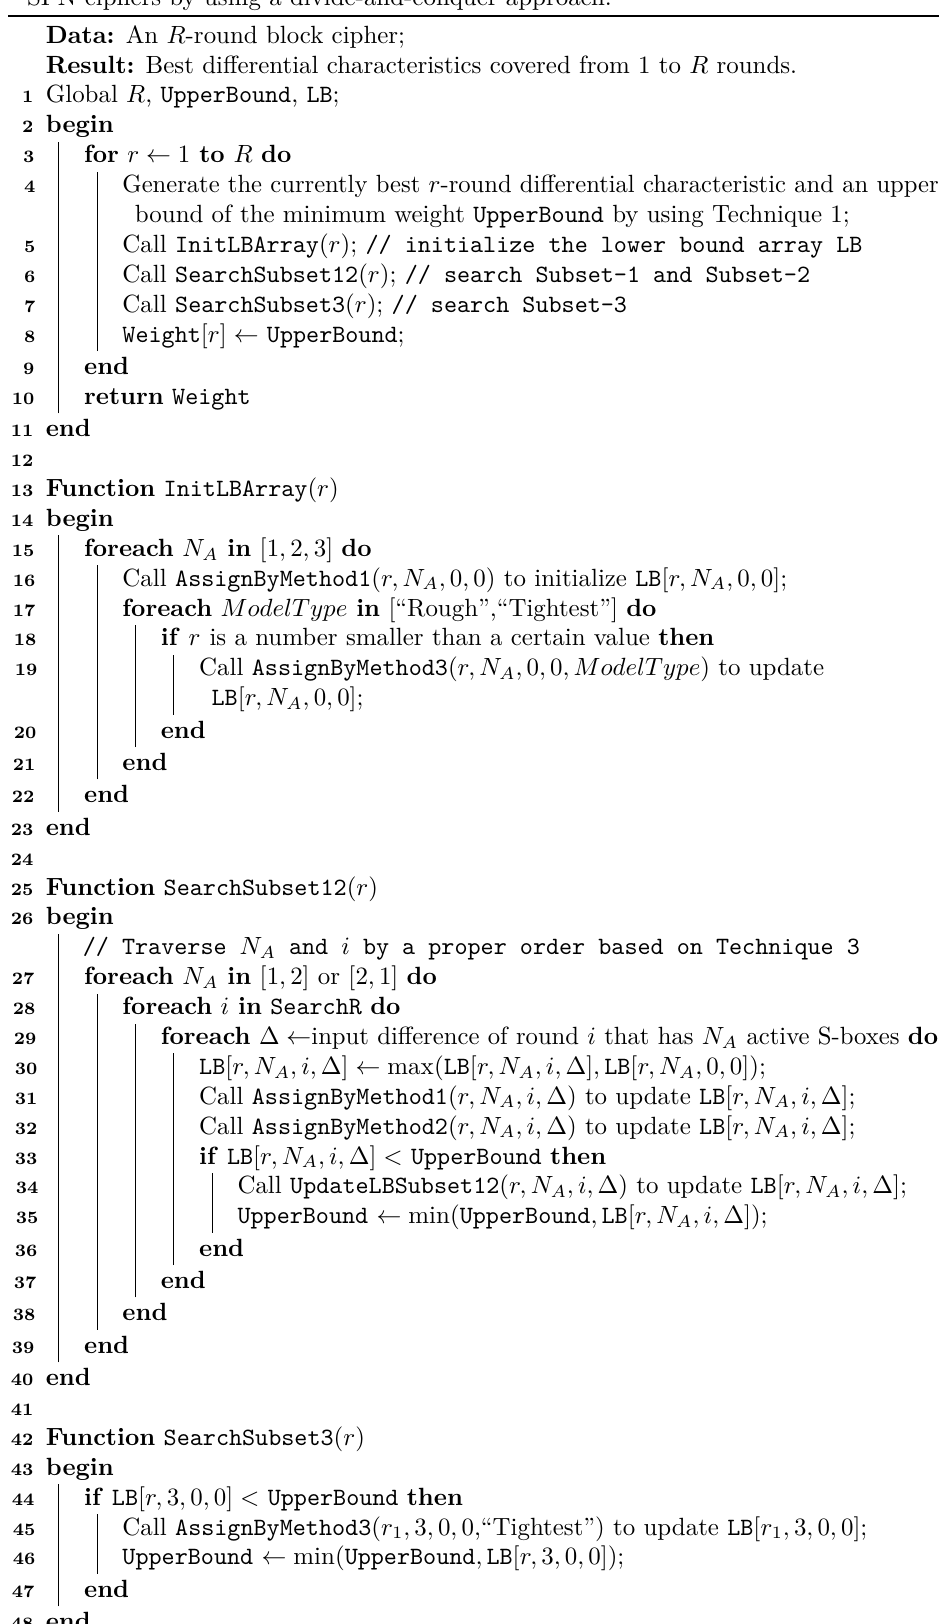
Algorithm 1: Process of searching for the best differential characteristics for SPN ciphers by using a divide-and-conquer